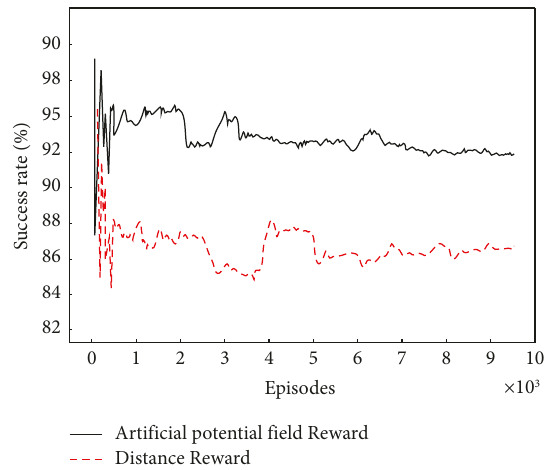
Figure 6: Change trend of the final success rate of